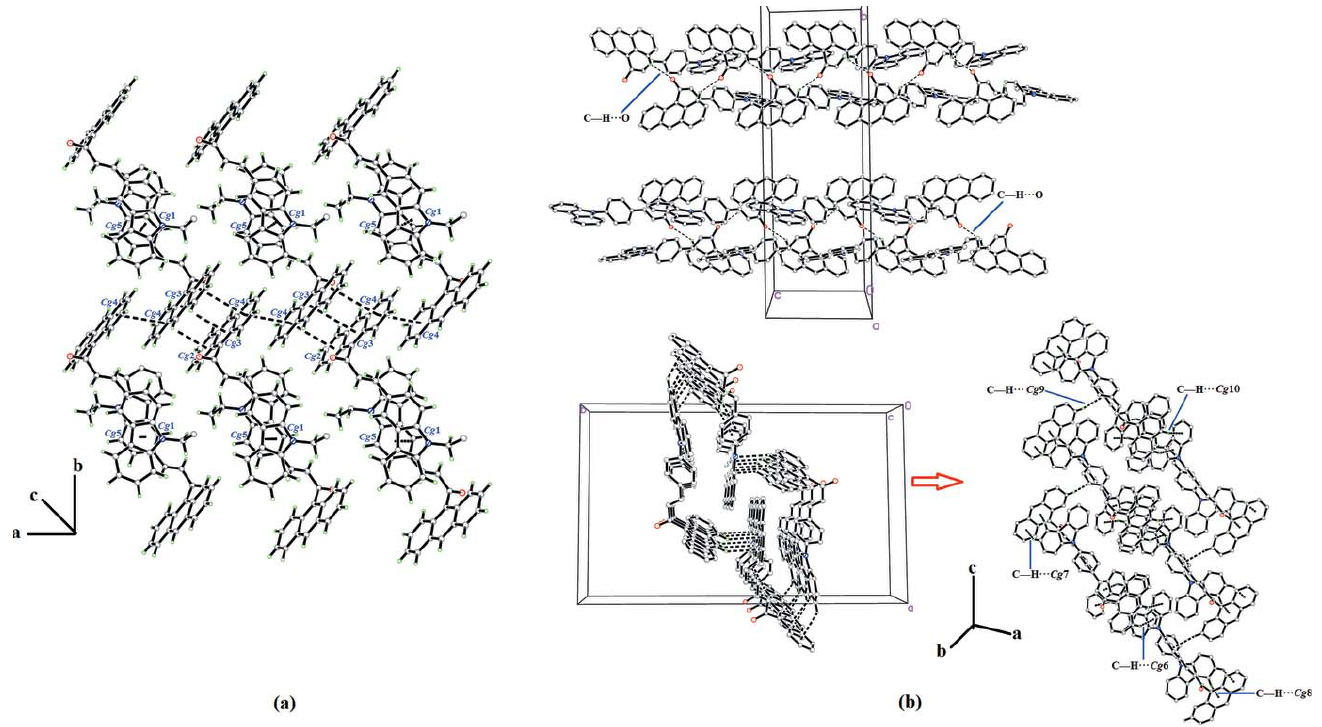
Figure 2 The crystal packing showing ( a ) weak (cid:2) – (cid:2) interactions in compound I and ( b ) weak C—H (cid:2)(cid:2)(cid:2) O and C—H (cid:2)(cid:2)(cid:2) (cid:2) interactions of compound II .